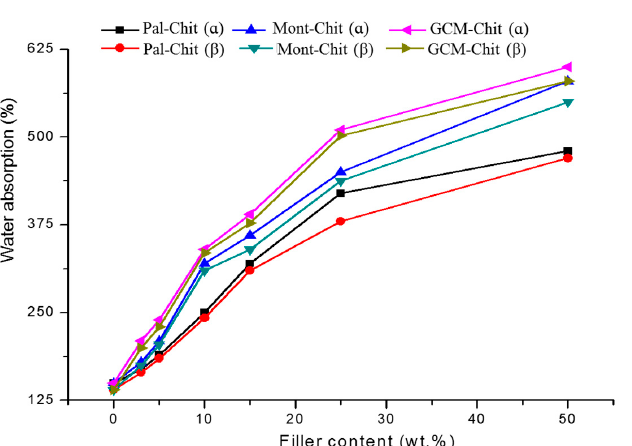
Figure 3. Variations in the amount of water absorbed by the composite films studied as a function of the additive contents. Chit: chitosan; Pal: palygorskite; Mont: montmorillonite; GCM: geopolymer-containing material.